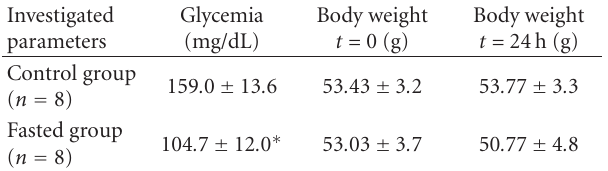
Table 1: Glycemia, body weight at time zero, and body weight after 24h of control and fasted mice. Data are mean ± SEM of 8 mice per group. Asterisks denote significant di ff erence ( ∗ P < 0 . 05) from values for control group as calculated by Student’s t